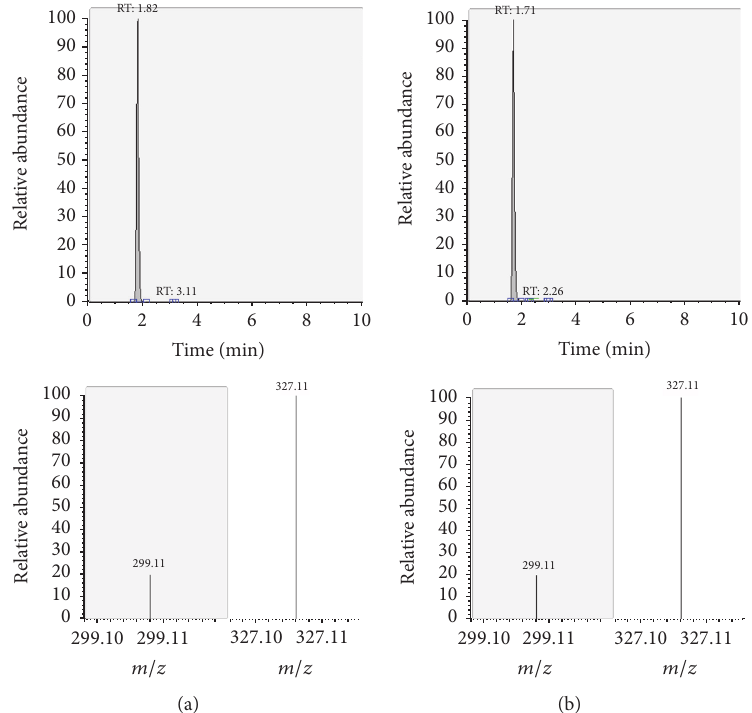
Figure 2: LC-MS/MS chromatograms of PDN and SRM transitions and relative abundances. (a) Standard in a 100 𝜇 g L −1 solution. (b) Standard in the spiked sample at 100mg kg −1 .